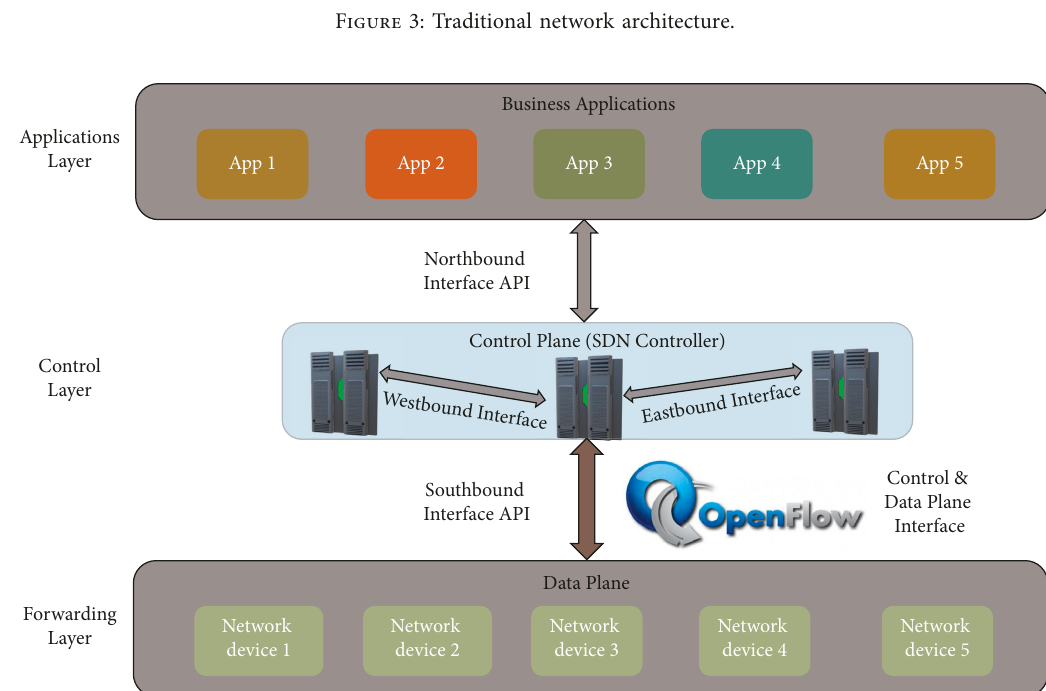
Figure 4: SDN network architecture.